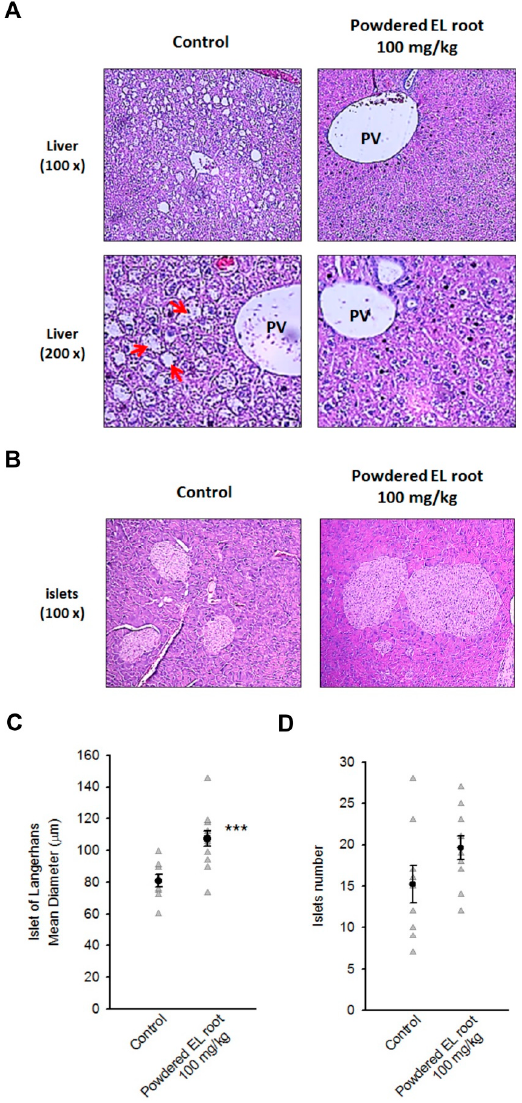
Figure 5. E. longifolia reduced glycogen accumulation in the hepatocytes, but improved pancreatic islet volume in db / db mice. ( A ) All db / db mice displayed glycogen hepatopathy. Treatment with EL powdered root obviously alleviated the masses of glycogen particles (arrow) inside the hepatocytes. ( B , C ) The representative images and corresponding quantification histogram showed an enlargement of pancreatic islets which was characterized after an 8-week administration of EL powdered root. The data represented the increase in islet volume in the EL-treated mice. ( D ) The number of islets did not di ff er significantly between the control and EL-treated group (*** p < 0.001, indicates a statistically significant di ff erence from the control